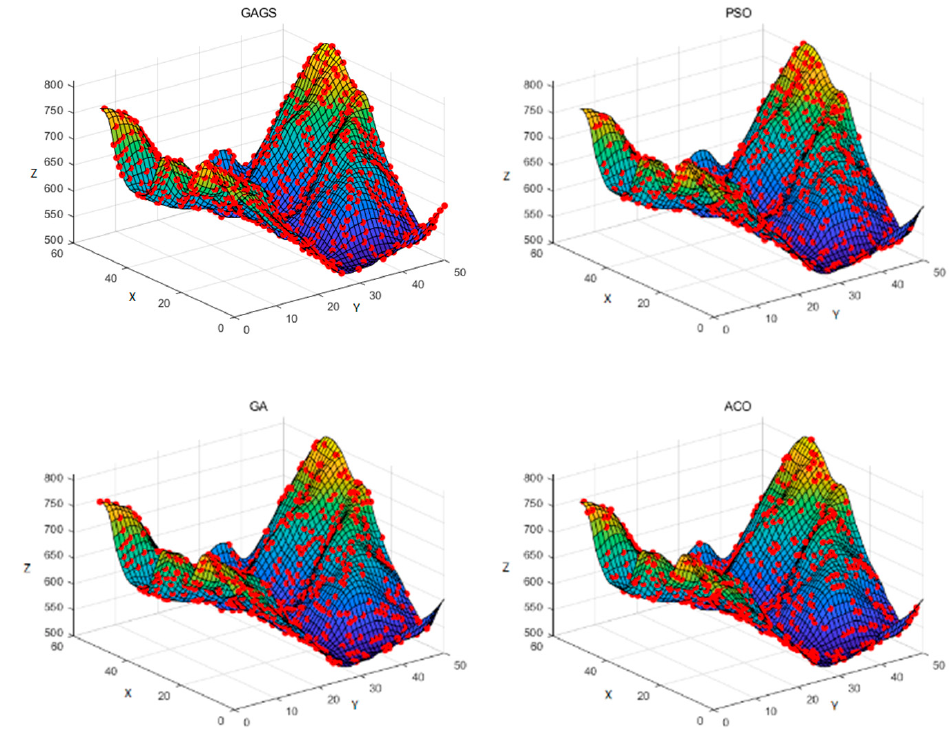
Figure 9. Node deployment under complex terrain model.